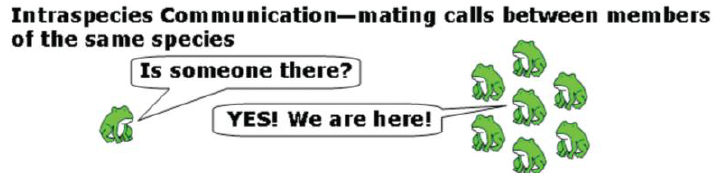
Figure 7. Intraspecies communication. Copyright 2009 Hiroki Kobayashi, with permission from [11].